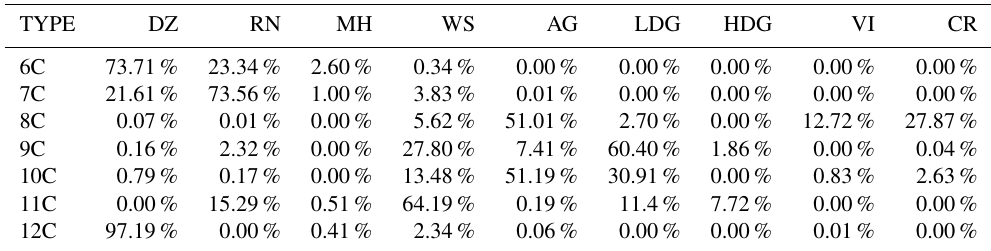
Figure 12. Same as Fig. 7, but for the convective regime of the dry season (LR is light rain, MR is moderate rain, HR is heavy rain, LDG is low-density graupel, HDG is high-density graupel, AG is aggregates, and IC is ice crystals). Table 6. Same as Table 3, but for the stratiform region of the dry